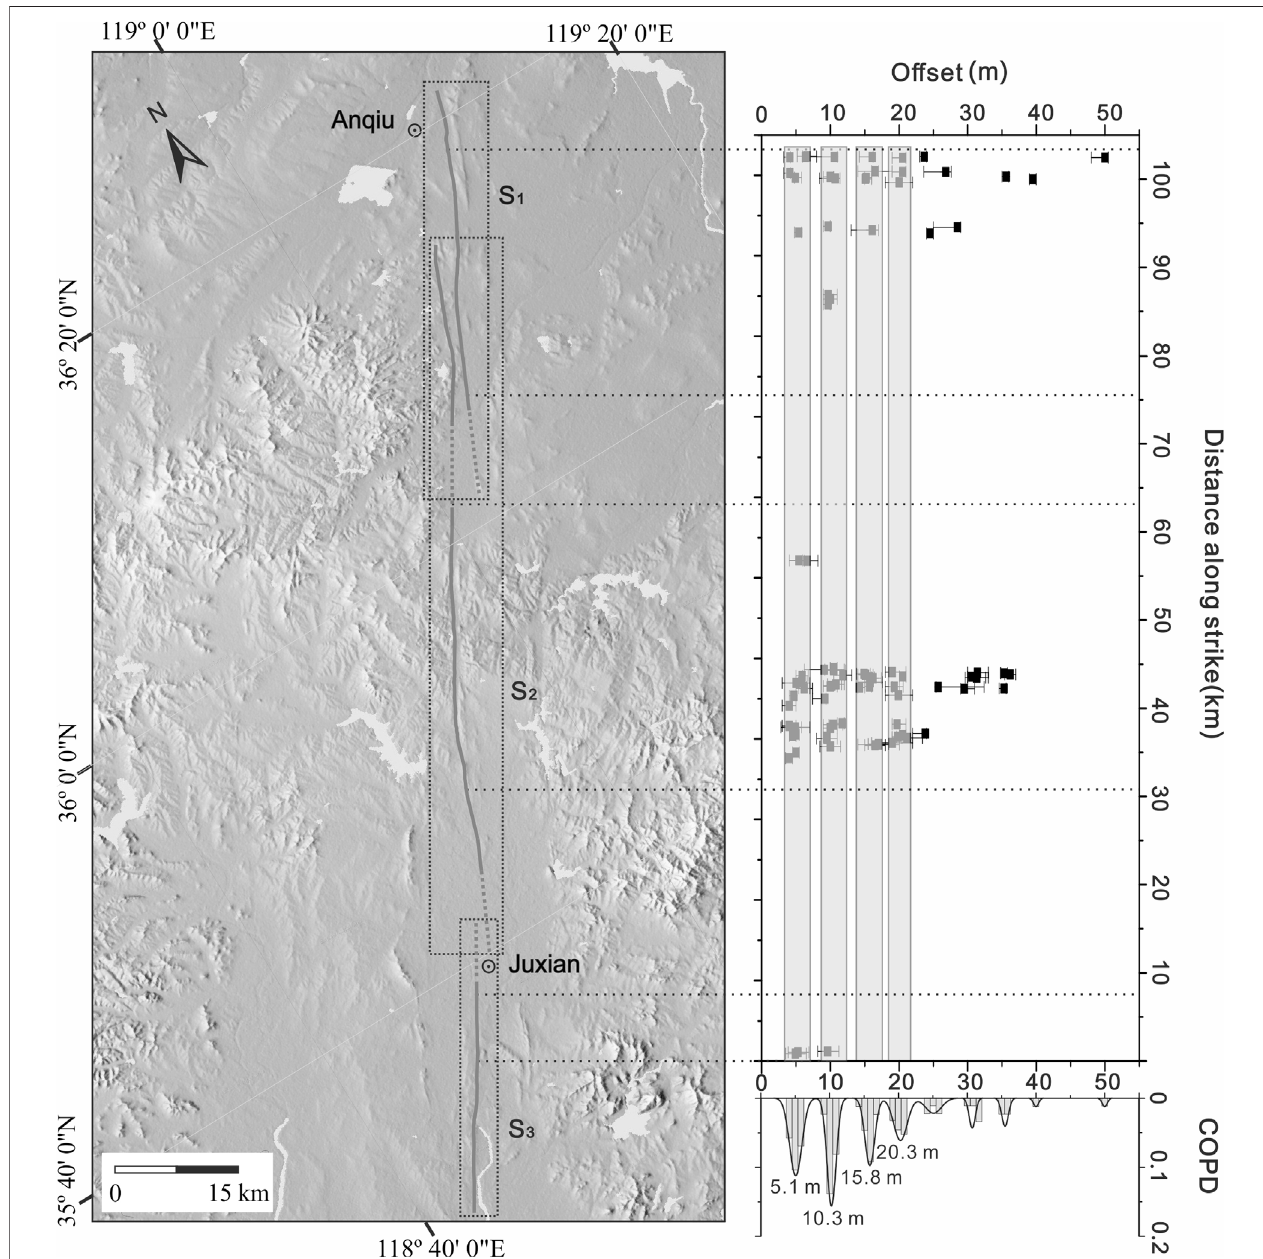
FIGURE4| Statistics and distribution ofthegullydislocations. Thedotted boxesshow segmentation oftheNAJF byWang et al.(2015).The scatter diagram inthe upper right corner shows the projection of theoffset gullies onto the NAJF.The line graph in thelower right corner shows the statistical frequency distribution ofthe gully offset datapoints. The fi gure has the same scope as Figure 1C